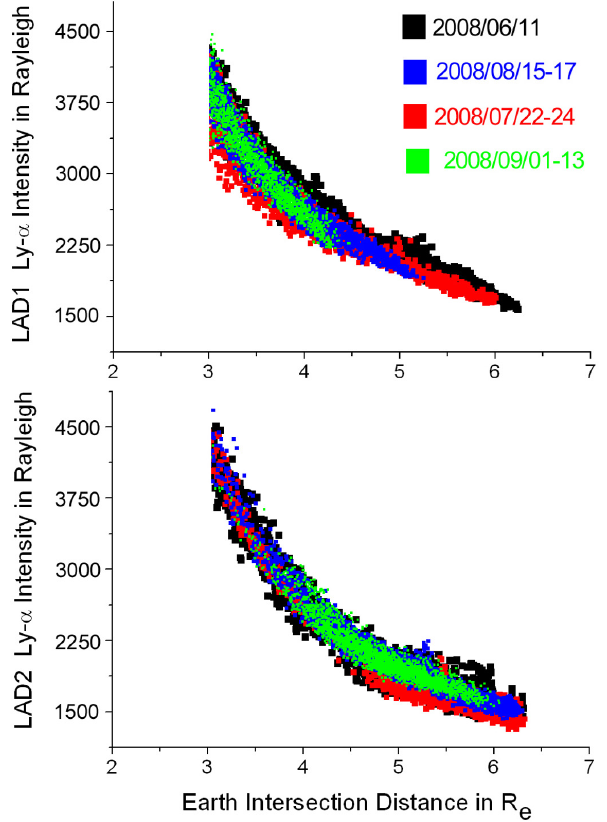
Fig. 1. The used TWINS1 LAD1 (upper section) and LAD2 (lower section) Lyman- α intensity data (uncleaned) versus their geocen- tric earth intersection distance (black=11 June, red=22–24 July, blue=15–17 August, green=1–13 September).